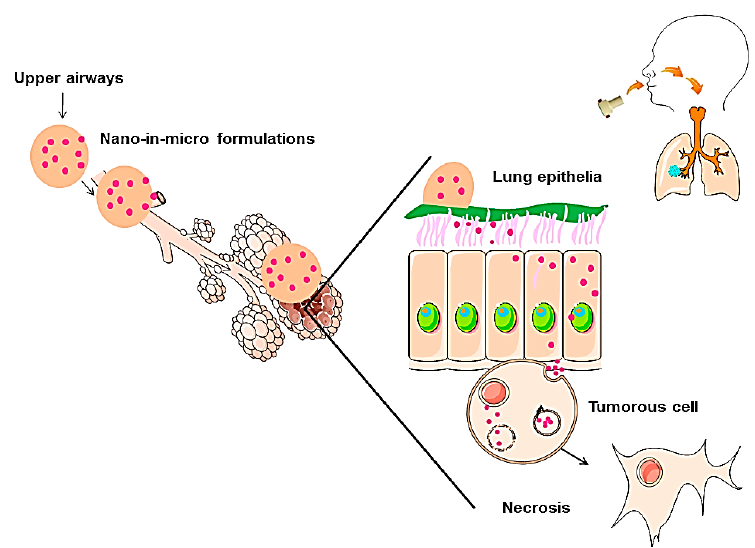
Figure 1. Mechanism of nanoparticle delivery through an aerosol of nano-in-micro formulations. Adapted from A. Silva et al. [20].